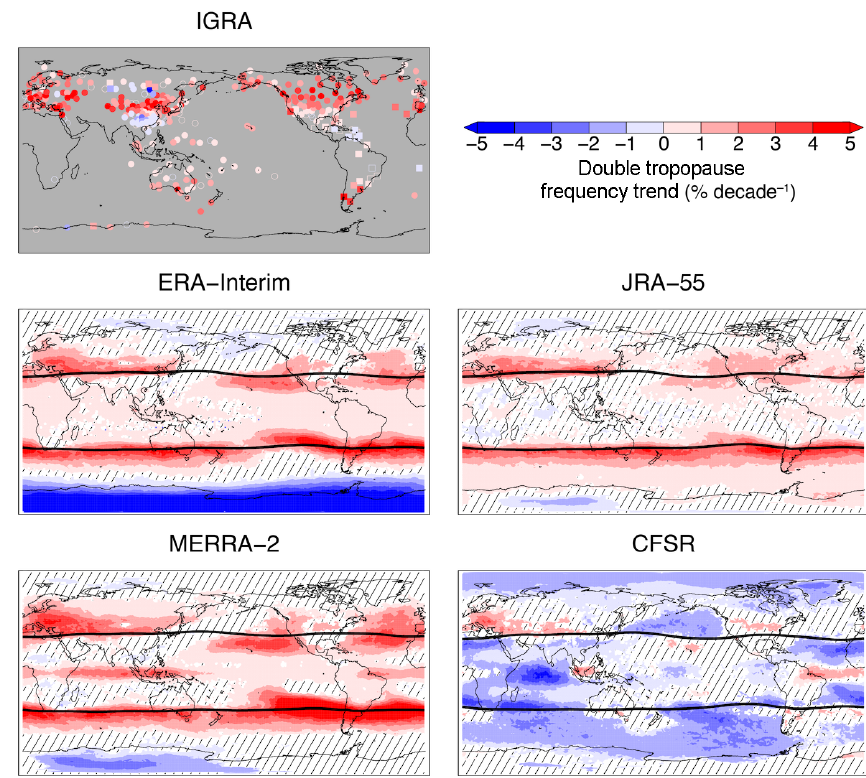
Figure 7. As in Fig. 4, but for trends in double tropopause frequency.